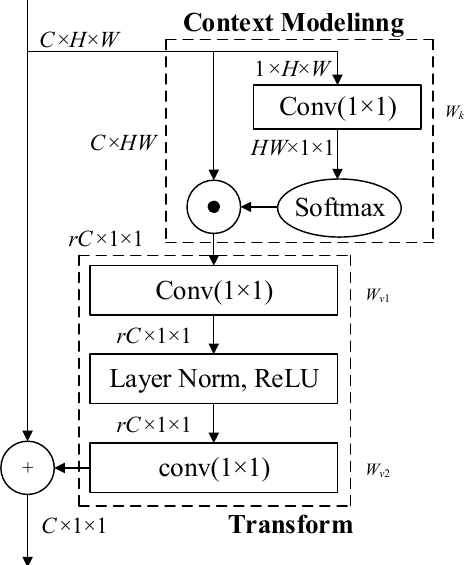
Figure 2. Architecture of the global context block.